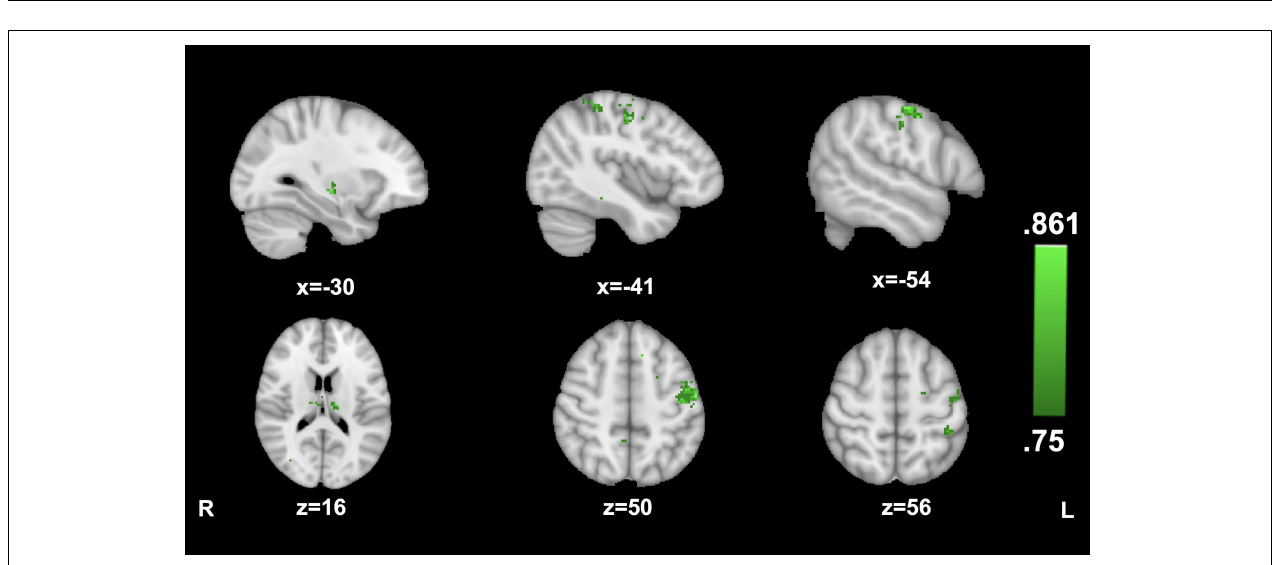
FIGURE 1 | Group GLM of seed connectivity with AI and PMC. Regions of significant connectivity with the seed regions during story listening. Red = The Hitcher, Green = The Living Room, Yellow = connectivity with the seed during both stories.